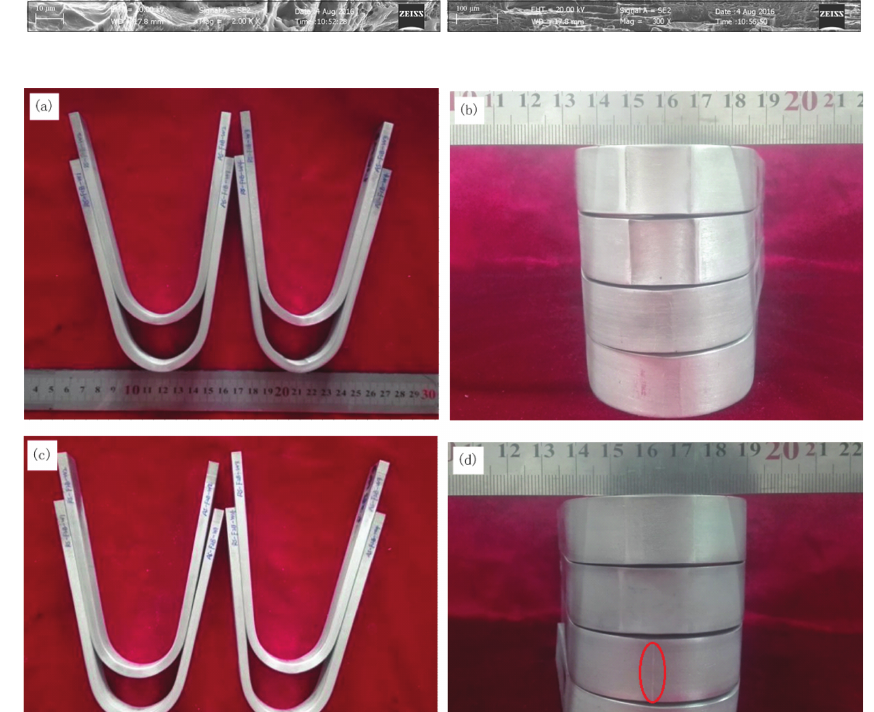
Figure 5: Fracture morphology of the original and repaired tensile samples: (a) (b) the original joint with tunnel defect; (c) the once repaired joint; (d) the twice repaired joint.